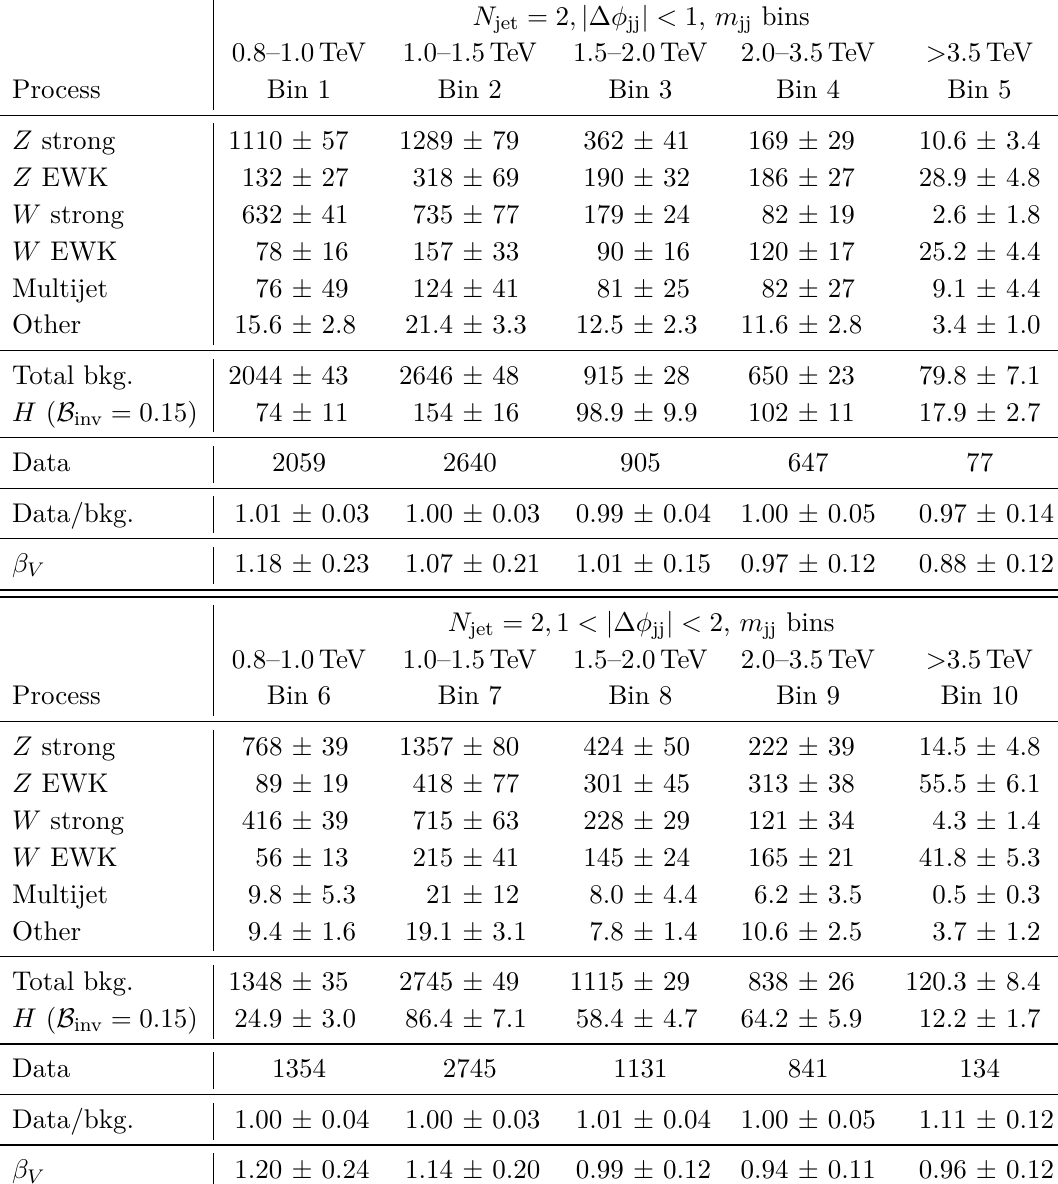
Table 6. Yields of data, signal and major backgrounds in the signal regions for each bin after the likelihood fit with µ set to zero. Minor backgrounds from t ¯ t , V V , V V V , and VBF H → W ∗ W / τ + τ − are combined and labelled ‘other’. The uncertainties in the backgrounds are derived by the fit and take into account the correlations of the background uncertainties. The predicted signal yields (VBF, ggF, and V H ) for B = 15% (the observed limit) are presented for comparison, along with their inv associated uncertainties, assuming that the experimental uncertainties are fully correlated between the ggF and VBF contributions. The β are the background normalisation V